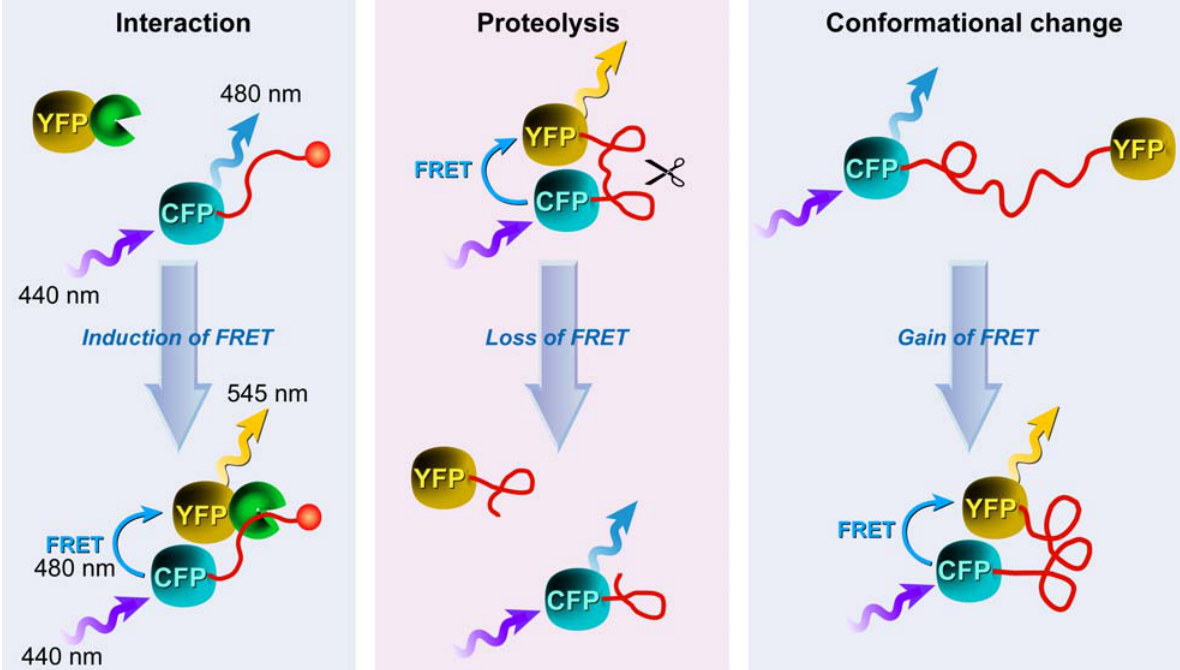
Figure 20. Three possible approaches for developing FRET biosensors. Based on